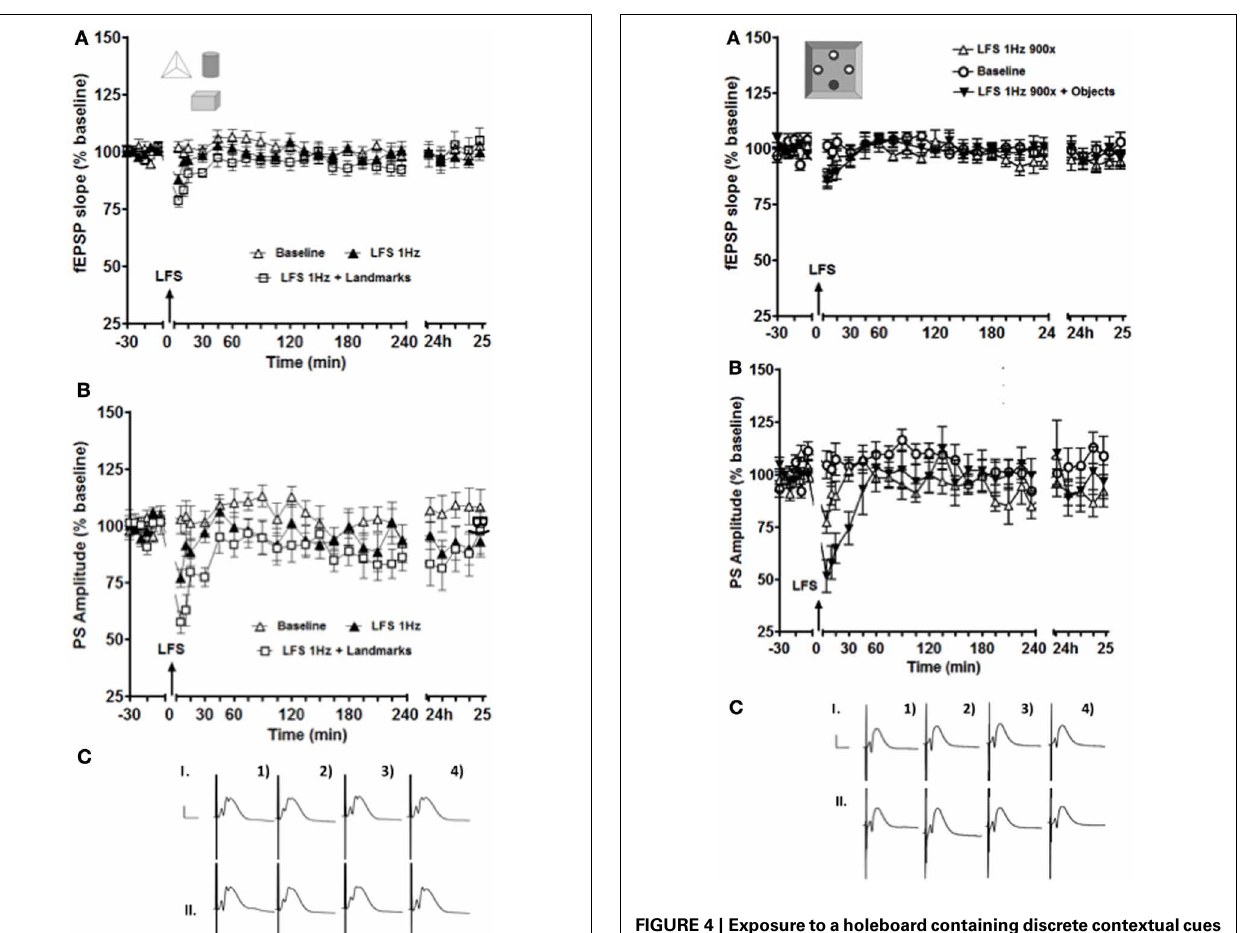
FIGURE 4 | Exposuretoaholeboardcontainingdiscretecontextualcues enhanced and prolonged the STD of the PS amplitude (B) but not of the fEPSP slope (A). The black inverted triangles represent data from an experiment where LFS was applied simultaneously with exposure to the objects,thewhitetrianglesrepresenttheresultsofanexperimentwhereLFS was applied alone, and the white circles show baseline test-pulse responses recorded from the same animals ( n = 13). (C) shows examples of analog recordings of intermediate DG potentials with (II) and without (I) object exposure 5min before (1), 5min after (2), 4h after (3), and 24h (4) after LFS. Vertical bar: 5mV, horizontal bar: